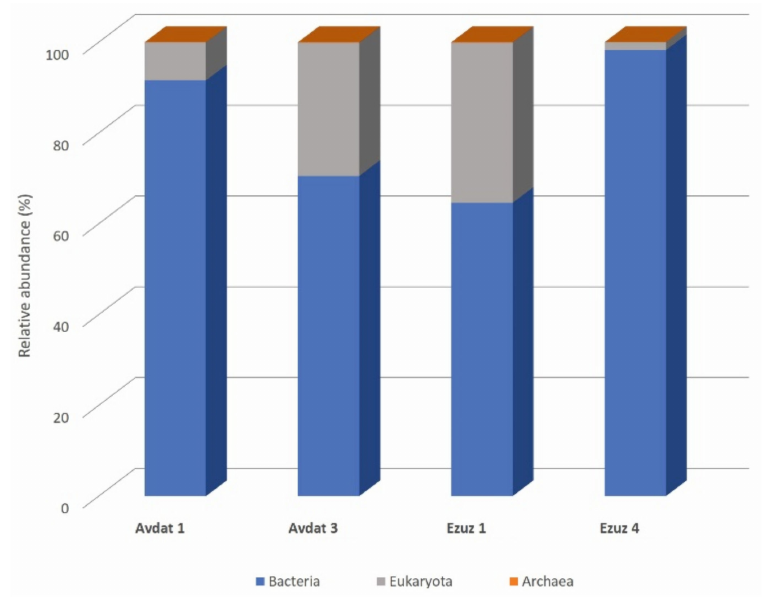
Figure 2. Relative abundance of bacteria, eukaryotes and archaea in the microbiomes of the four samples analyzed.